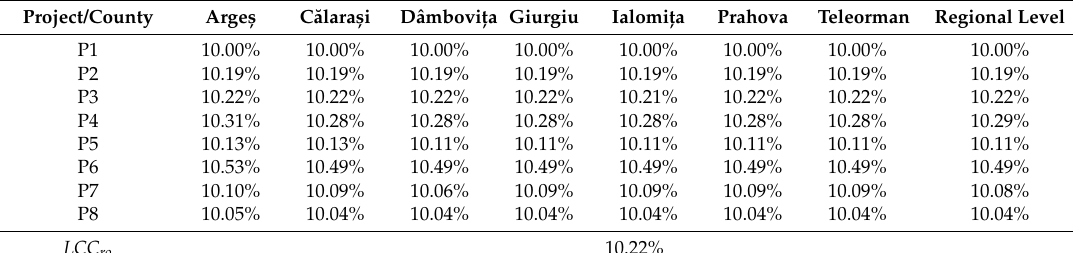
Table 8. LCC variation at the regional level for the maximum scenario (%) in the case of the increase of all key variables (implementation, maintenance and energy costs) by 10% 1